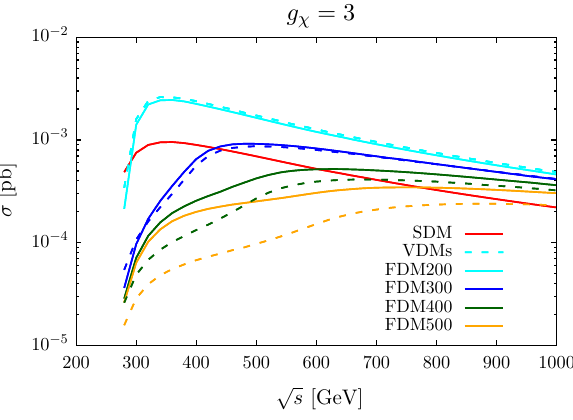
Fig. 2 The background cross section (left) and signal-to-background ratio (right) with varying electron and position beam polarization at the √ s = 500 GeV. In the right panel, the benchmark point of FDM200